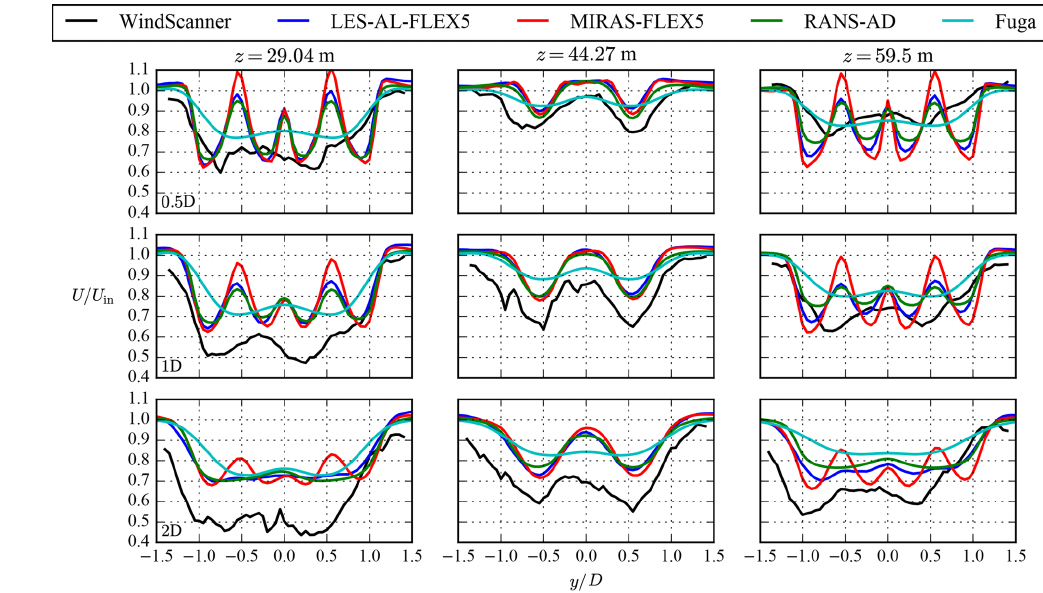
Figure 13. Near-wake case: profiles of stream-wise velocity at three heights and three downstream distances.